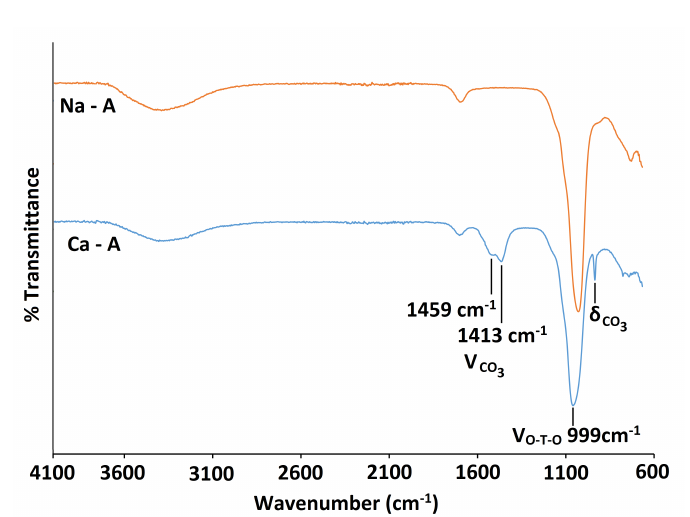
Figure 11. 13 C CPNMR of Ca-A.